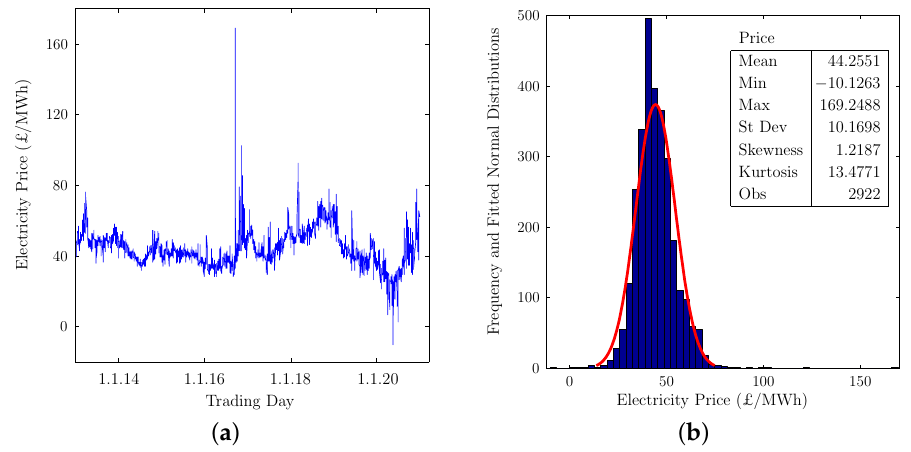
Figure 1. Electricity prices on the N2EX market during 1 January 2013–31 December 2020.